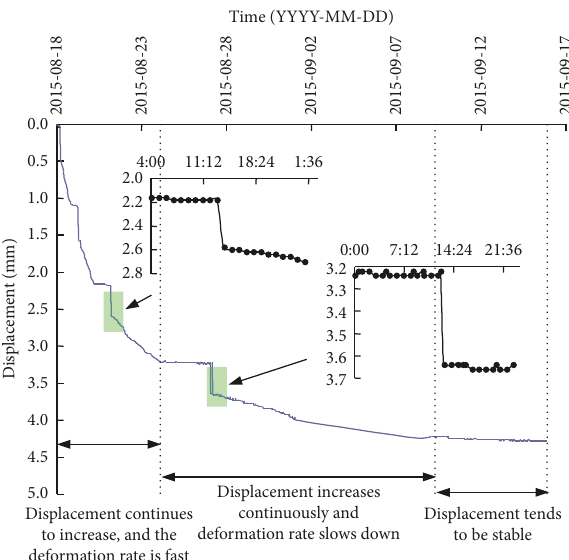
Figure 9: Displacement-time curves of the surrounding rock at the cross section of